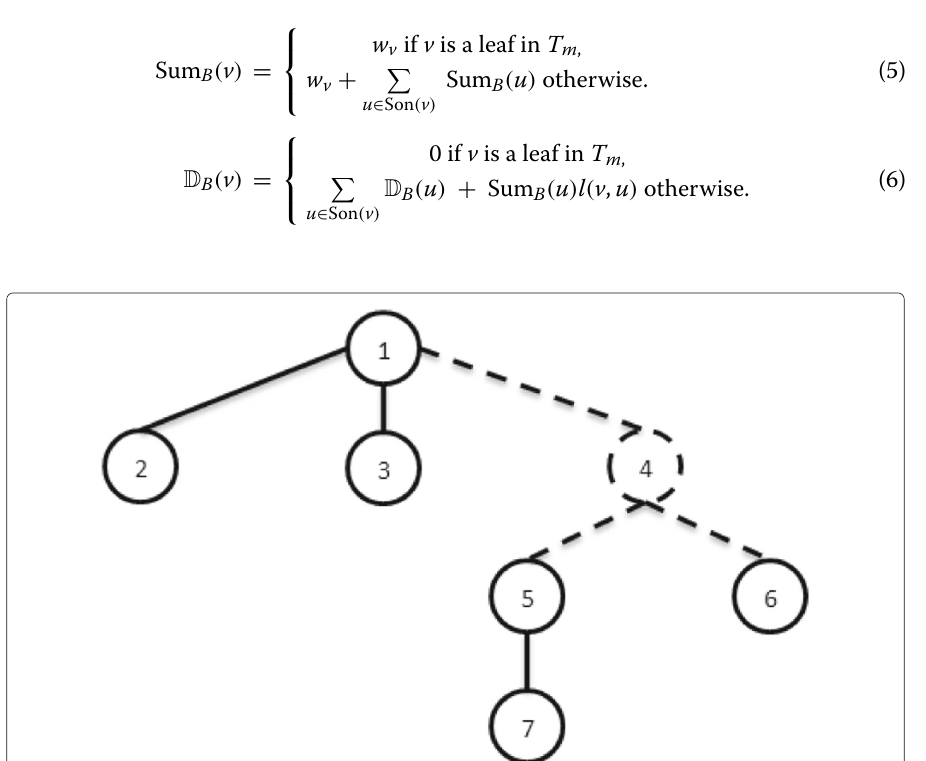
into two subtrees T 1 = ( V 1 , E 1 ) and T 2 = ( V 2 , E 2 ) such that V 1 ∪ V 2 = V , V 1 ∩ V 2 = { m } , E 1 ∪ E 2 = E , and | V 1 | = n 1 , | V 2 | = n 2 . Let Son ( 1, m ) and Son ( 2, m ) be the sets of the sons of the middle vertex m in T 1 and T 2 , respectively. Denote by Sum B ( v ) and D B ( v ) the sum and the sum of weighted distances of the vertices in T B of weights of vertices in T B v vertex v , respectively, see [5]. By scanning from the leaves to the root, Sum B ( v ) and D B ( v ) are computed in O ( n ) time as follows: